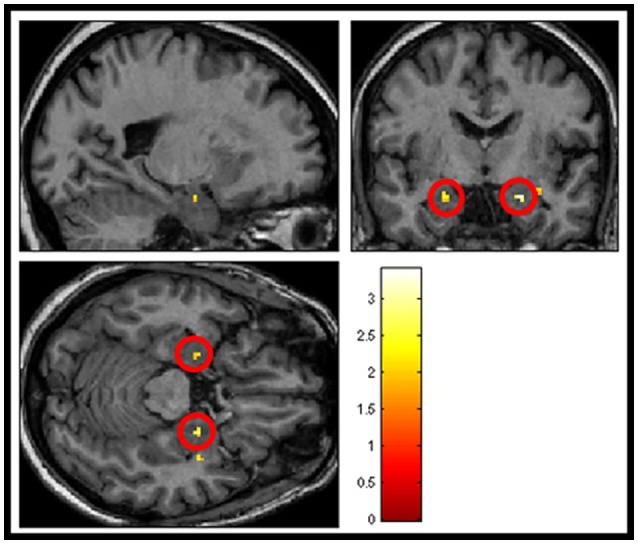
Shows group averaged (n = 23) activation of amygdala structures (circled in red) in response to salience > neutral sound condition, masked with amygdala template (p < 0.05 uncorrected).